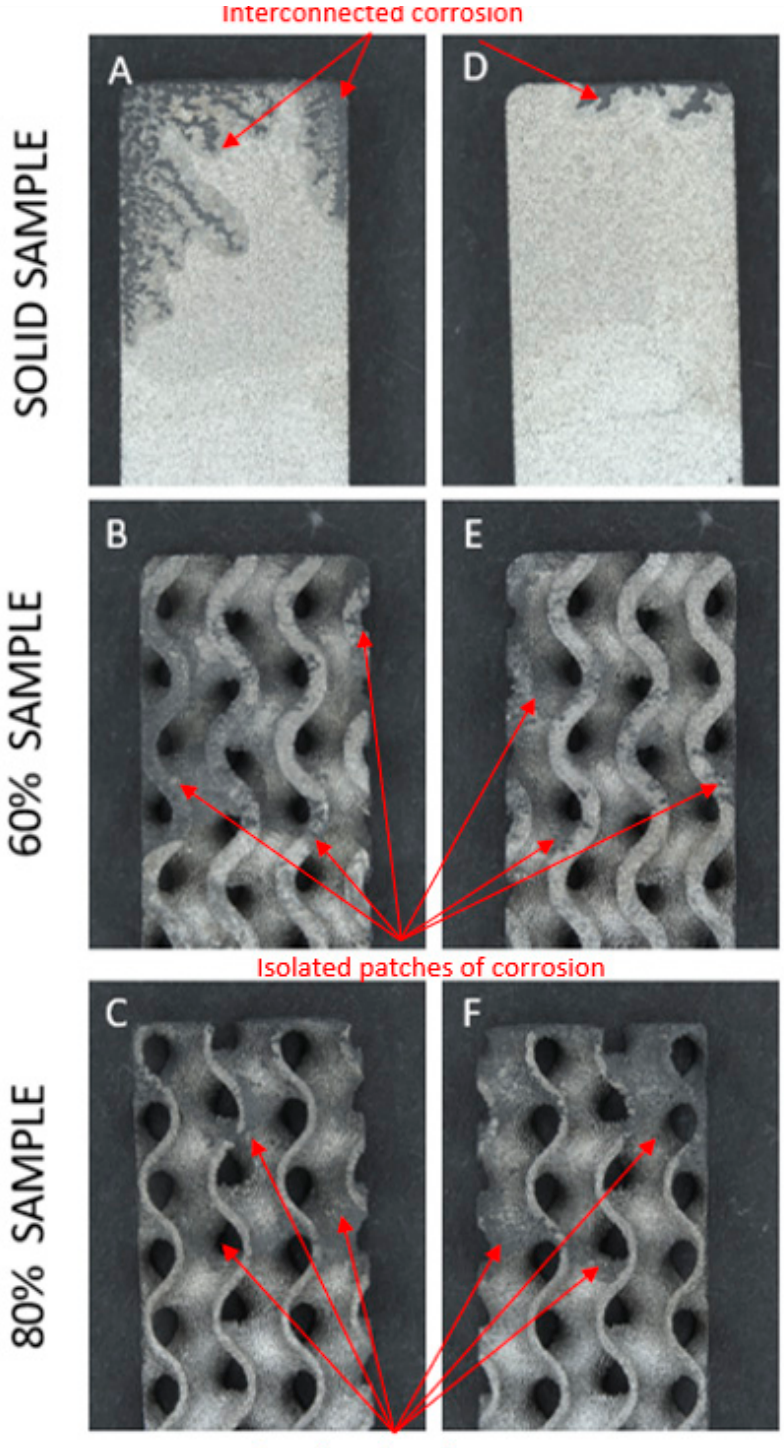
Figure 5. Stereozoom images of corrosion coverage on both faces of ( A , D ) solid sample; ( B , E ) 60% porous gyroid sample; and ( C , F ) 80% porous gyroid sample. All samples are Ti6Al4V and produced via LPBF. Corrosion was highly variable on sample surfaces and focused on raised edges and sample corners. Sections of corrosion indicated in red and characterized by discoloration and/or loss of material.